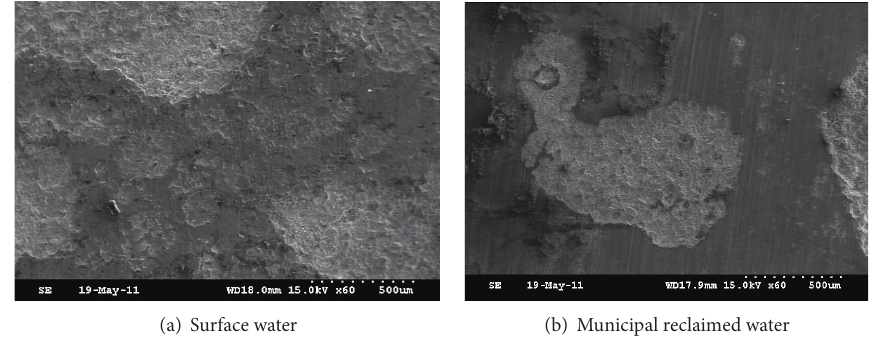
Figure 5: Morphology of foulants in recycling cooling water system makeup by municipal reclaimed water and surface water by SEM.